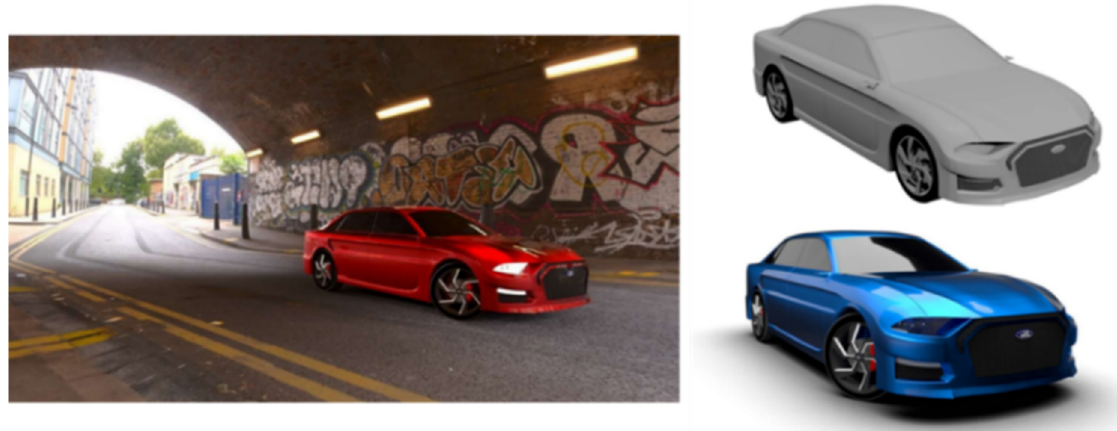
Figure 8. 3D representation of the car model and rendering.